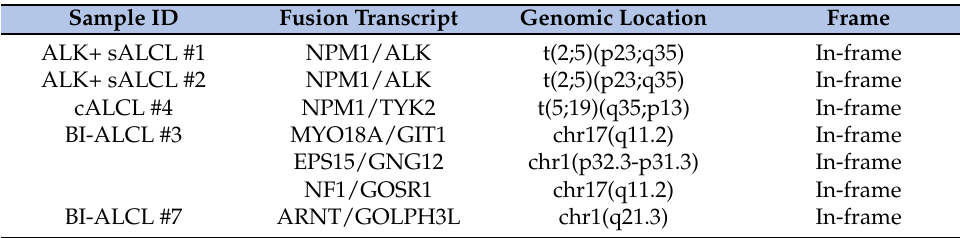
Table 2. Fusion transcripts in cALCLs and BI-ALCLs.